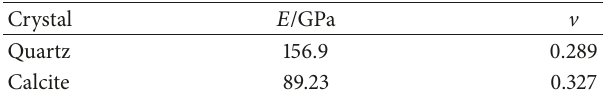
Table 8: Elastic modulus and Poisson’s ratio of the two mineral crystals.